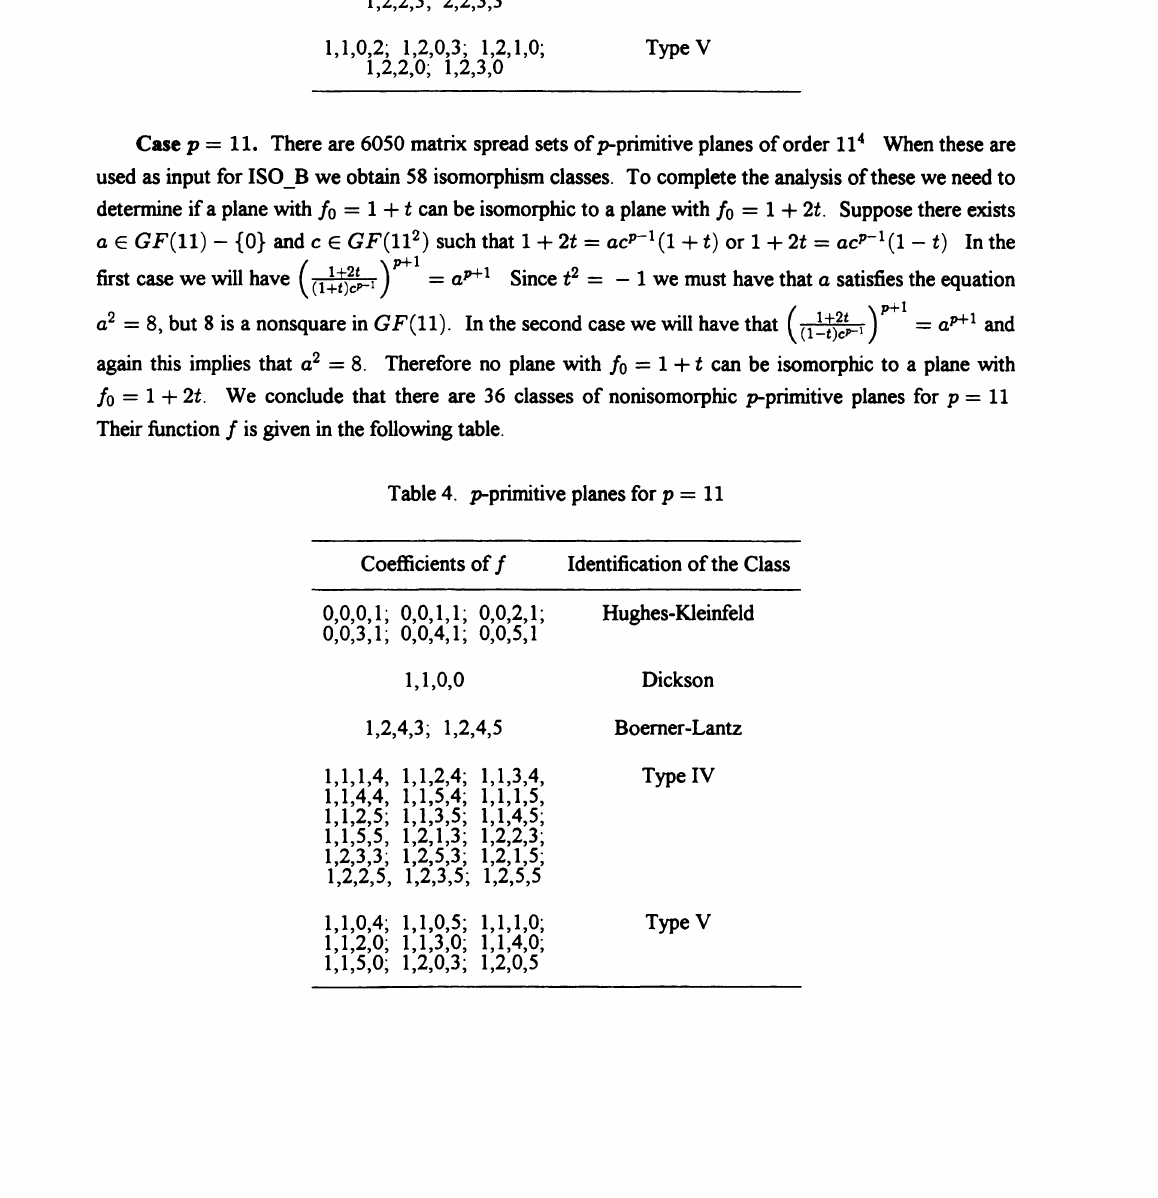
Table 3. p-primitive planes for p